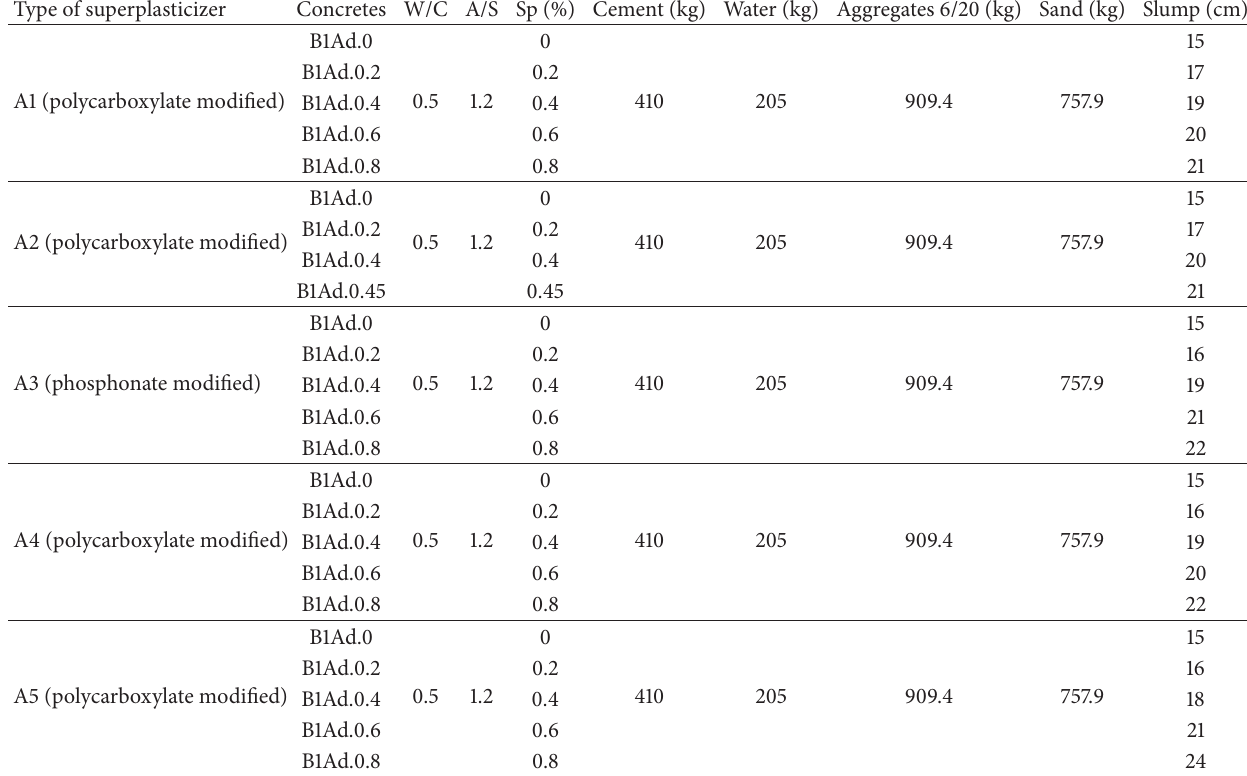
Table 2: 2nd test program: tested concretes’ composition with five superplasticizers of two different natures. Type of